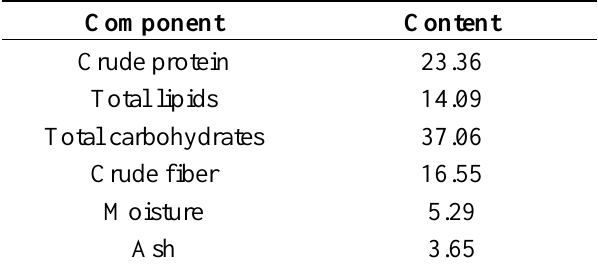
Table 2. Percent proximate composition of I. hederacea